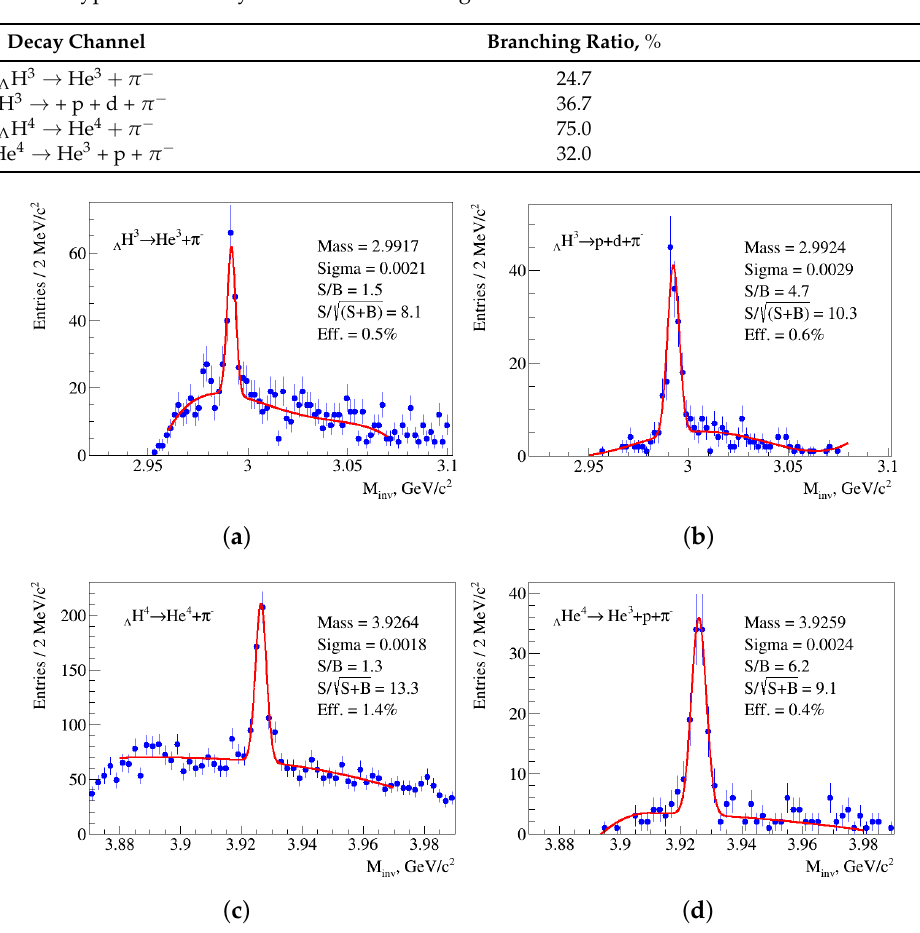
Figure 6. Reconstructed invariant mass spectra of hyperon decay products: ( a ) Ξ + → Λ + K + . 8 · 10 6 events from PHSD [24] simulation of minimum bias Au+Au collisions at ( c ) Ω been processed. Histograms are fitted to a sum of a Gaussian and a polynomial. The numbers in the legends present mean and sigma of the Gaussian as well as signal/background ratio, significance, and signal reconstruction efficiency, where the signal and background are calculated within a ± 2 σ interval of the peak position, and efficiency is taken with respect to all hyperons produced within 50 cm of the interaction point. Table 1. Hypernuclei decay modes and branching ratios.